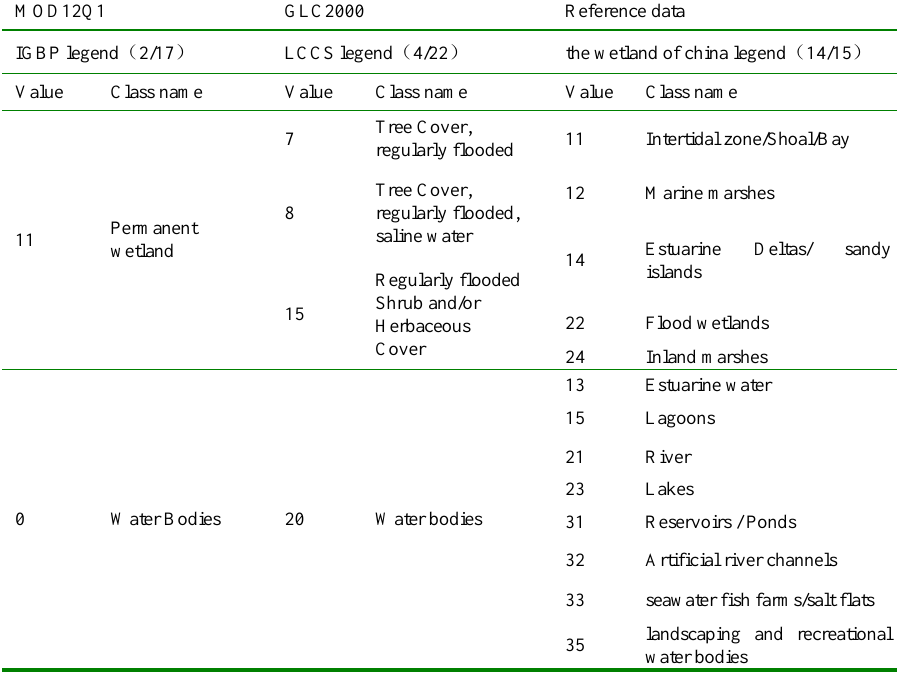
Table 1 the crossover between different classification